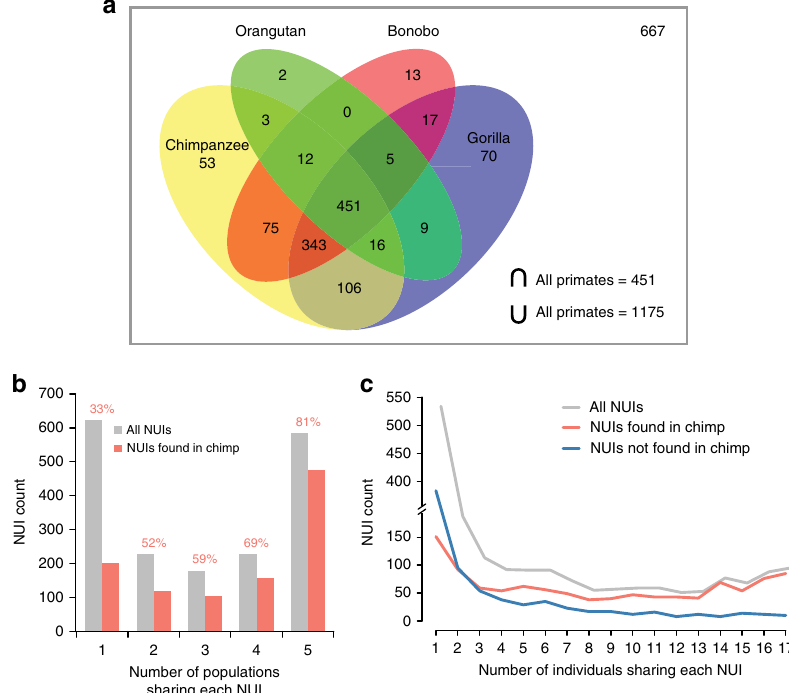
Fig. 2 Non-reference unique insertions in non-human primates. a Venn diagram illustrating the number of NUIs found in non-human primate genomes. The gray box represents the universe, which includes 658 NUIs that were not found in any non-human primate genomes. b NUI frequency strati fi ed based on the number of populations sharing these sequences. Frequencies are further broken down depending on whether they aligned to the chimpanzee genome. The numbers on top of the bars represent the percentages of NUIs identi fi ed in the chimpanzee genome ( χ 2 = 309.5, p = 9.71e − 66). c As in b but at the